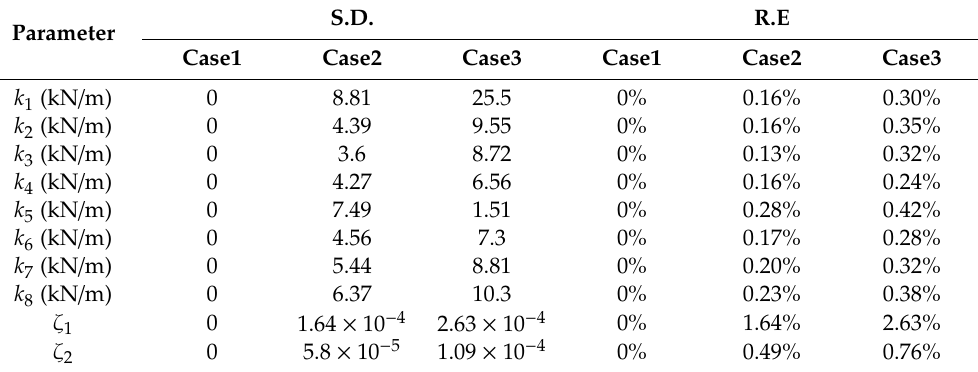
Table 3. Statistics of the posterior parameter distribution with the relative error (R.E.) between the posterior mean and the true value, including the standard deviation (S.D.) for each scenario.